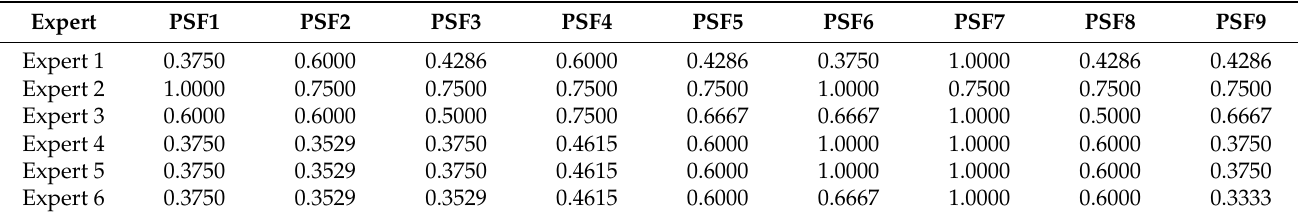
Table 10. The grey relation coefficient of each PSF’s impact in ST 1.1 concerning each expert’s